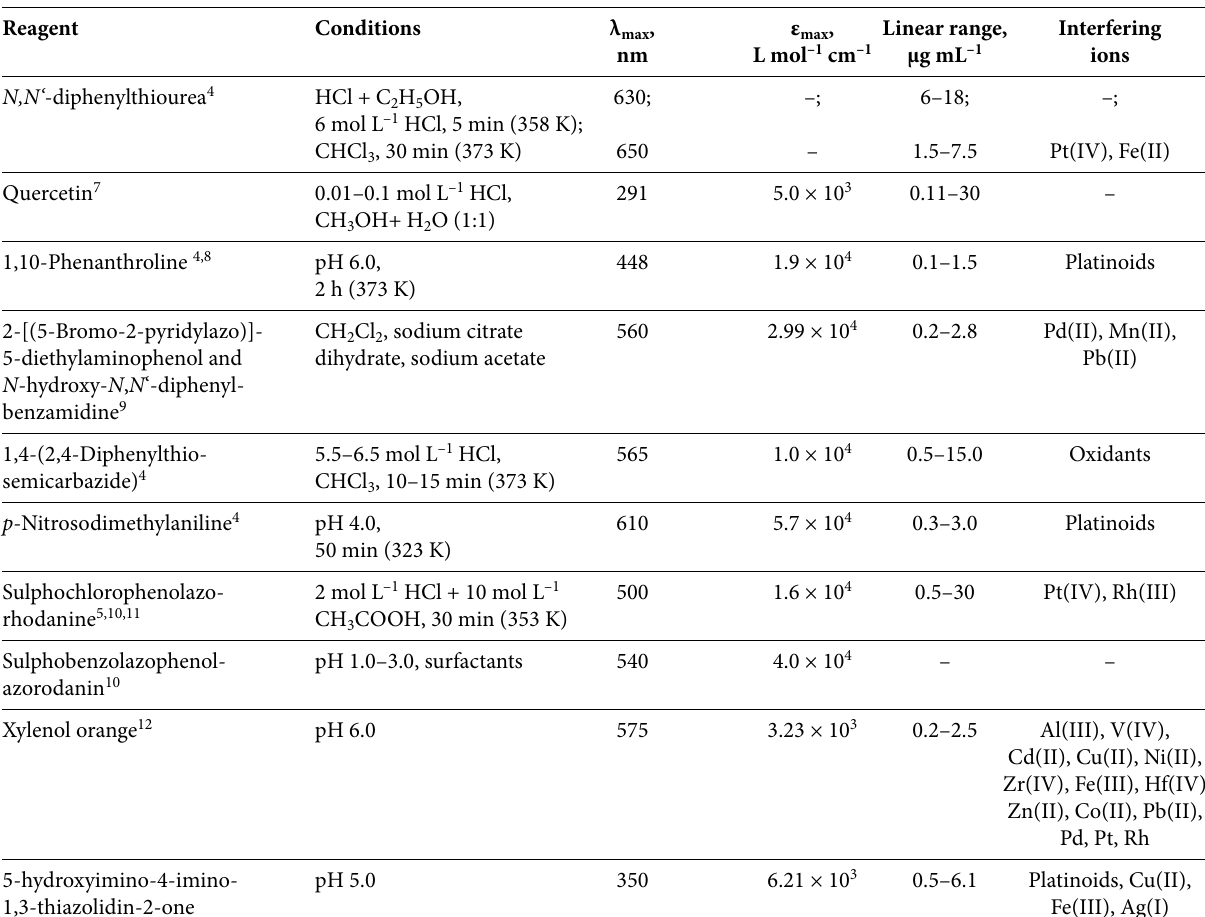
Table 5. Comparison of the proposed method with other spectrophotometric methods for the determination of ruthenium(IV) Reagent